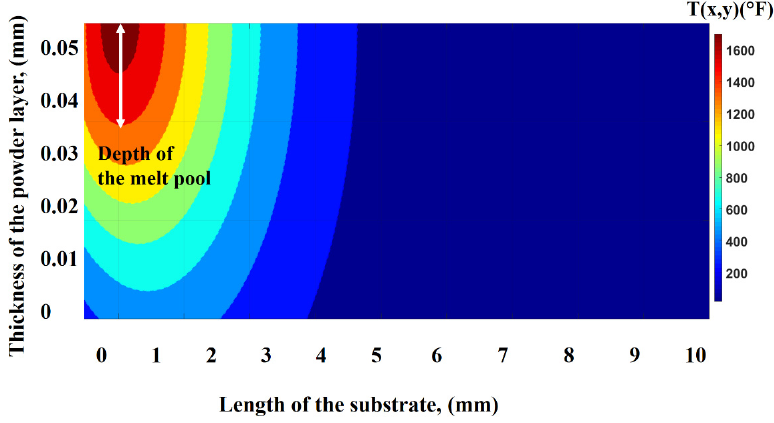
Figure 12. Thermal distributions across the thickness of the powder bed.